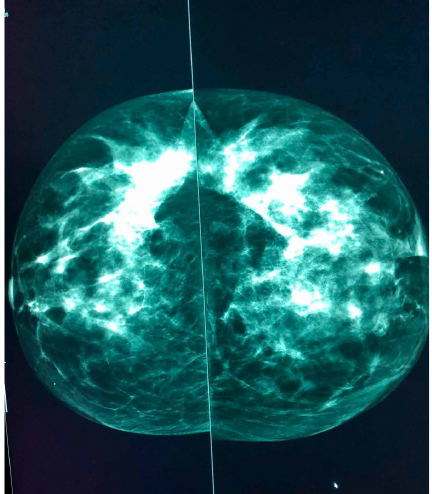
Figure 3: Mammogram CC view showing dense breasts (inconclusive).